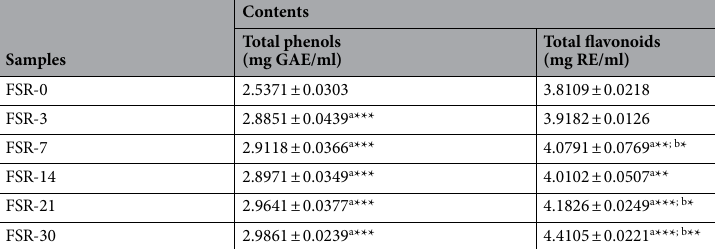
Table 5. Total phenolic contents and total flavonoid contents in fermentation solution of Rosa ‘Dianhong’ (FSR). Values are shown as means ± SD ( n = 3). Different numbers of asterisks represent different levels of significance from one-way ANOVA: a compared with FSR-0, b compared with the previous sample; * P < 0.05; ** P < 0.01; *** P < 0.001. GAE, gallic acid equivalents; RE, rutin